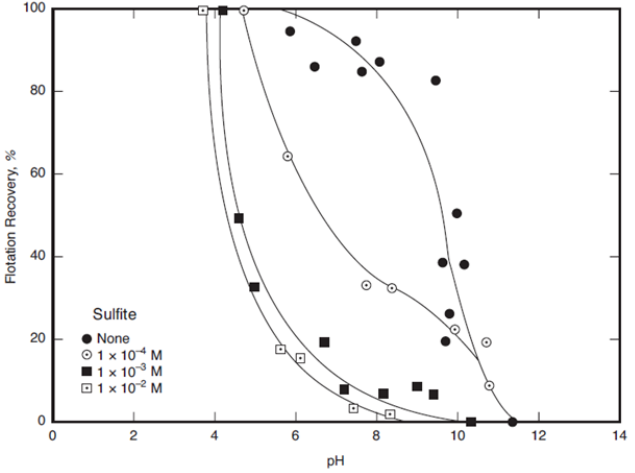
Figure 35. Pyrite recovery as a function of pH with 2 × 10 −4 M ethyl xanthate in the absence and presence of sodium sulfite as a depressant (adapted from Miller [154]).